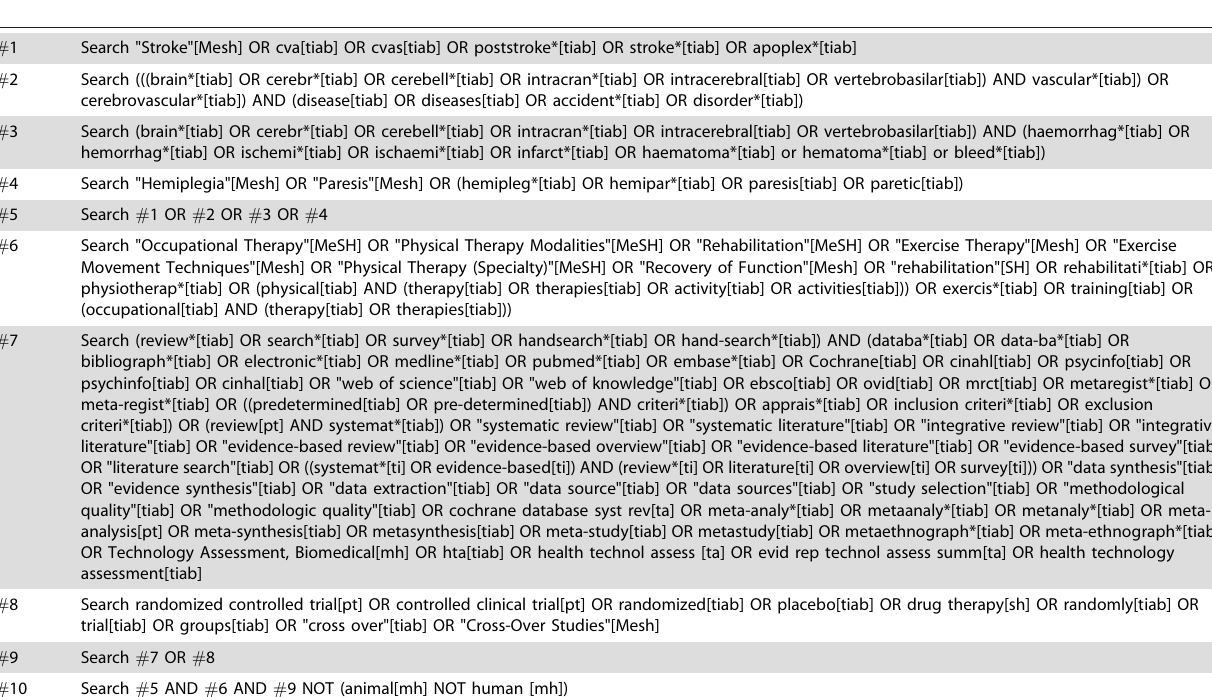
Table 1. Search strategy